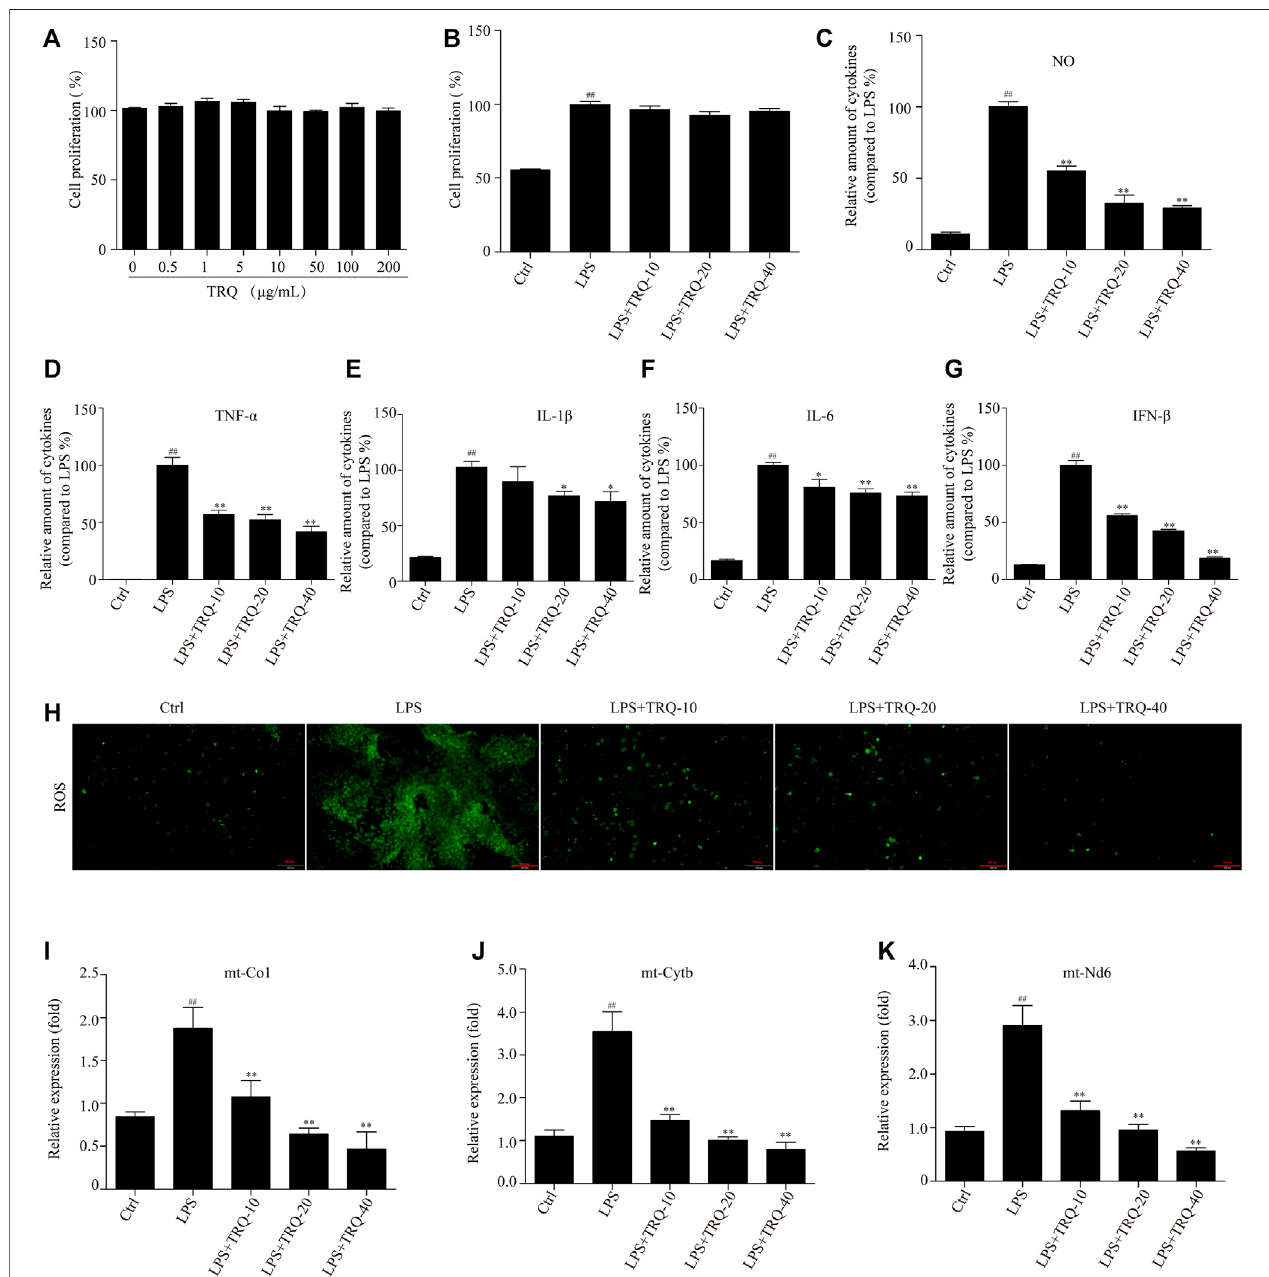
FIGURE7| TRQsuppressedin fl ammatoryresponses,ROSproduction,andmtDNAreleaseinLPS-stimulatedRAW264.7cells. (A) Thecellproliferationdetected byCCK-8. n (cid:2) 3. (B) ThecellproliferationdetectedbyCCK-8inthepresenceofLPS. n (cid:2) 5. (C – G) TheproductionofNO,TNF- α ,IL-1 β ,IL-6,andIFN- β inLPS-stimulated RAW 264.7 cells. n (cid:2) 6. (H) The ROS production was detected by staining with DCFH-DA. n (cid:2) 5. (I) qRT-PCR analysis showing expression of mtDNA. n (cid:2) 4. ## p < 0.01 vs. Ctrl group; *p < 0.05 and ** p < 0.01 vs. LPS group,